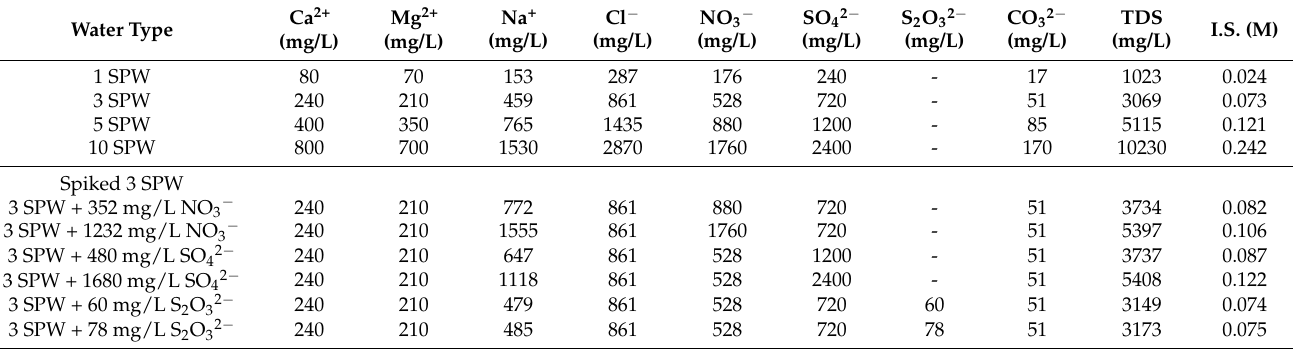
Table 1. Concentrations of ions for the various water qualities, showing the TDS and I.S for each water type. Ca Water Type